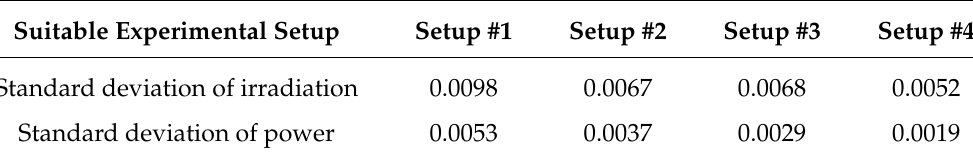
Table 3. Standard deviation of the difference between the mathematical model and measured